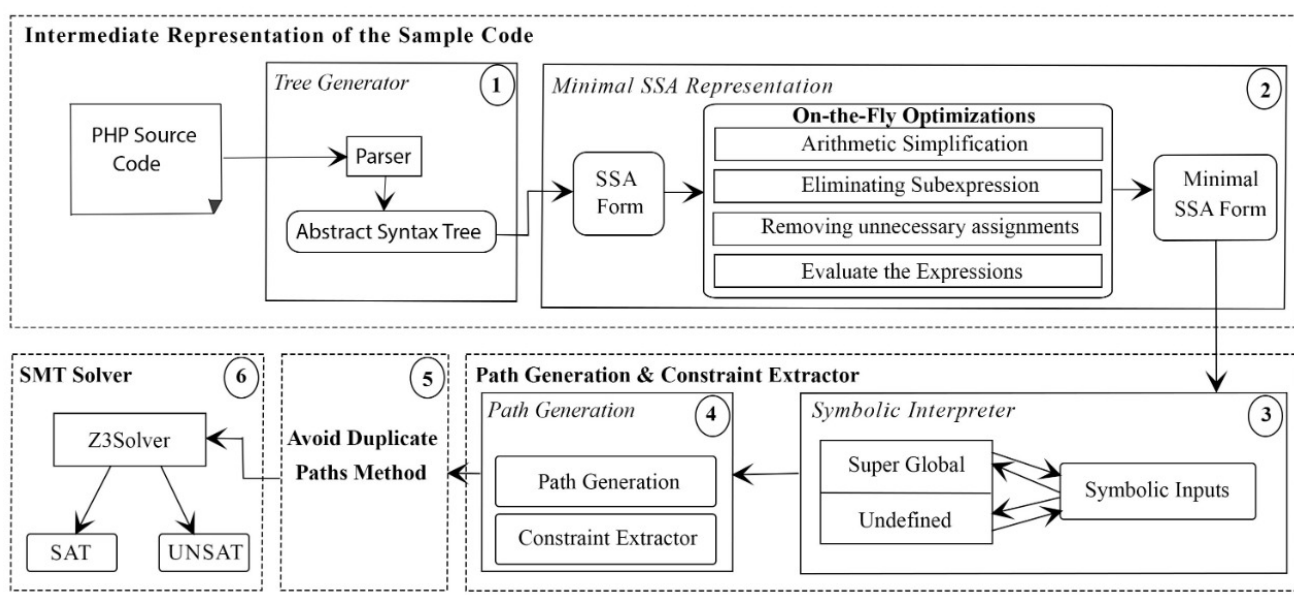
Figure 4. The framework of the proposed